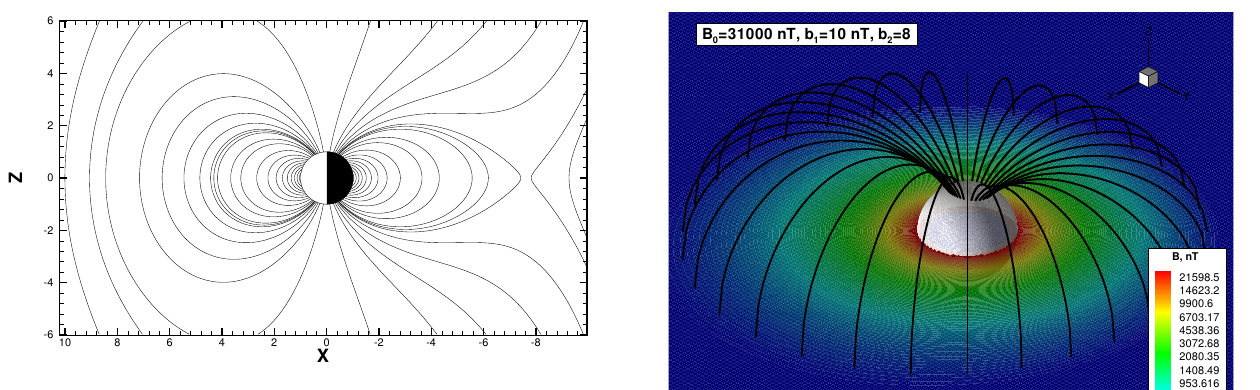
Fig. 1. Field lines of a compressed dipole in the noon-midnight meridional plane for B 0 = 31000 nT, b 1 = 10 nT, b 2 = 8 . Fig. 2. Three-dimensional view of a compressed dipole field lines with B 0 = 31000 nT, b 1 = 10 nT, b 2 = 8 . The color code shows the equatorial magnetic (cid:2)eld intensity. The sphere represents the Earth ( r = 1 ).